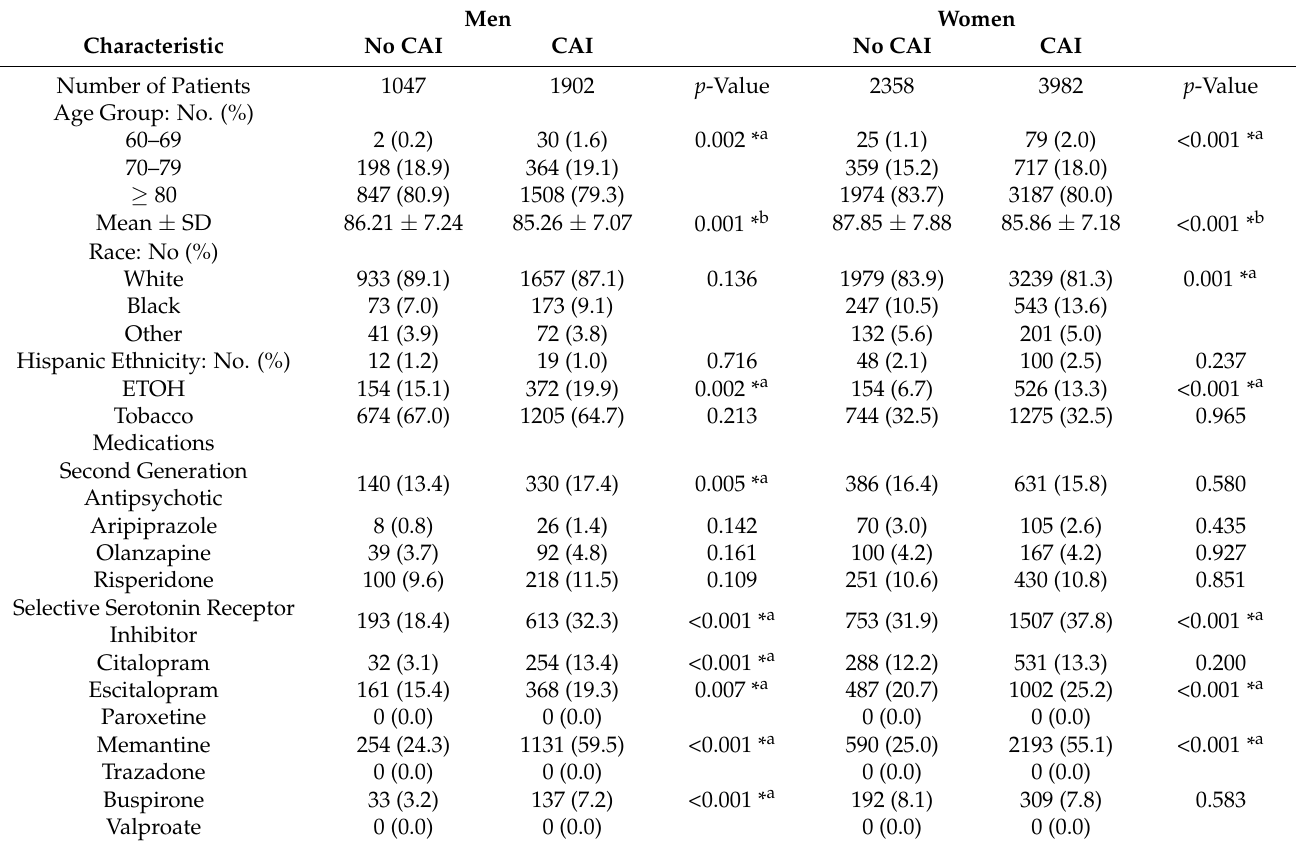
Table 2. Comparison of Demographics and Clinical Characteristics of Late-Onset Alzheimer’s Disease Patients who were taking a Central Acetylcholinesterase Inhibitor dependent on Gender. Men